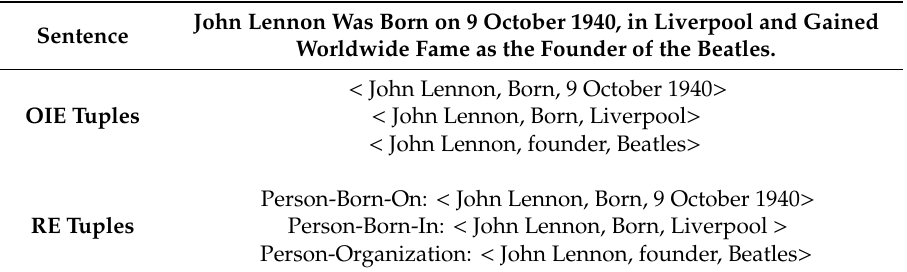
Table 1. Open information extraction and relation extraction